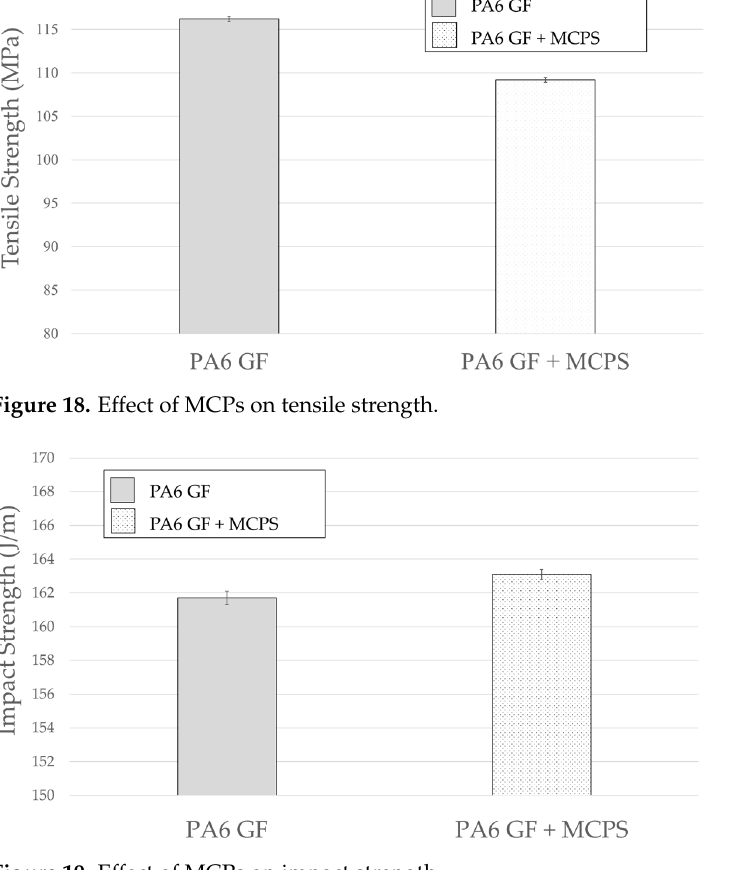
Figure 19. Effect of MCPs on impact strength.